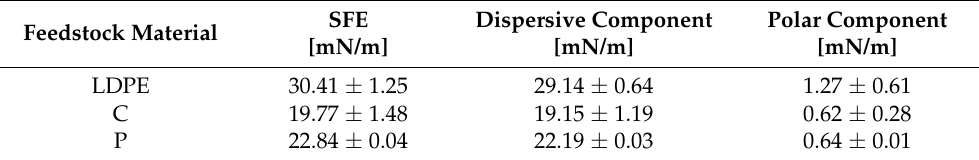
Table 5. Surface free energy (SFE) values with dispersive and polar components of low-density polyeth-ylene (LDPE), fully hydrogenated cottonseed oil (C), and paraffinic wax (P), in the form of